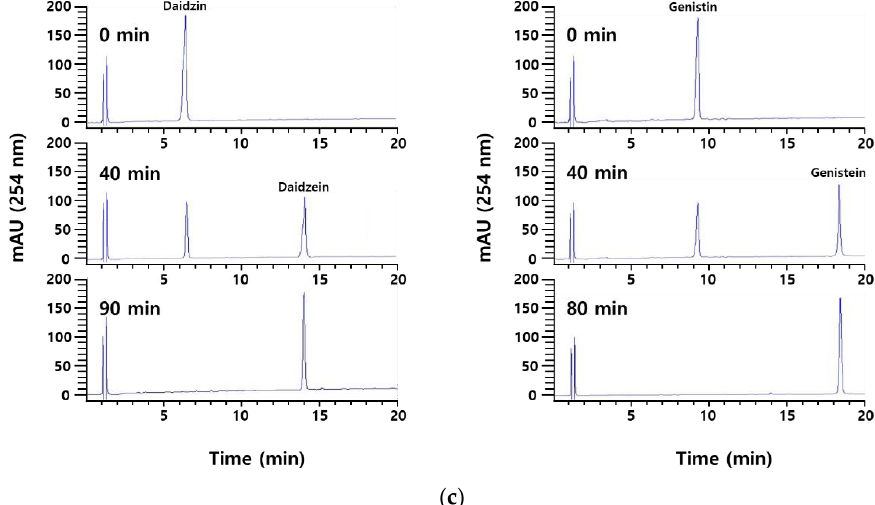
Figure 4. Time-course reactions for the biotransformation of reagent grade daidzin and genistin into daidzein and genistein by β -galactosidase from T. Uzoniensis . ( a ) Biotransformation of daidzin (open circle) into daidzein (closed circle). ( b ) Biotransformation of genistin (open square) into genistein (closed square). ( c ) HPLC profiles for the biotransformation of daidzin and genistin into daidzein and genistein. The reactions were performed at 90 °C in 50 mM CPB (pH 5.0) containing 3 mM isoflavone substrate and 0.2 mg/mL enzyme. Data are represented as the means of thriplicate experiments and error bars represent the standard deviation.